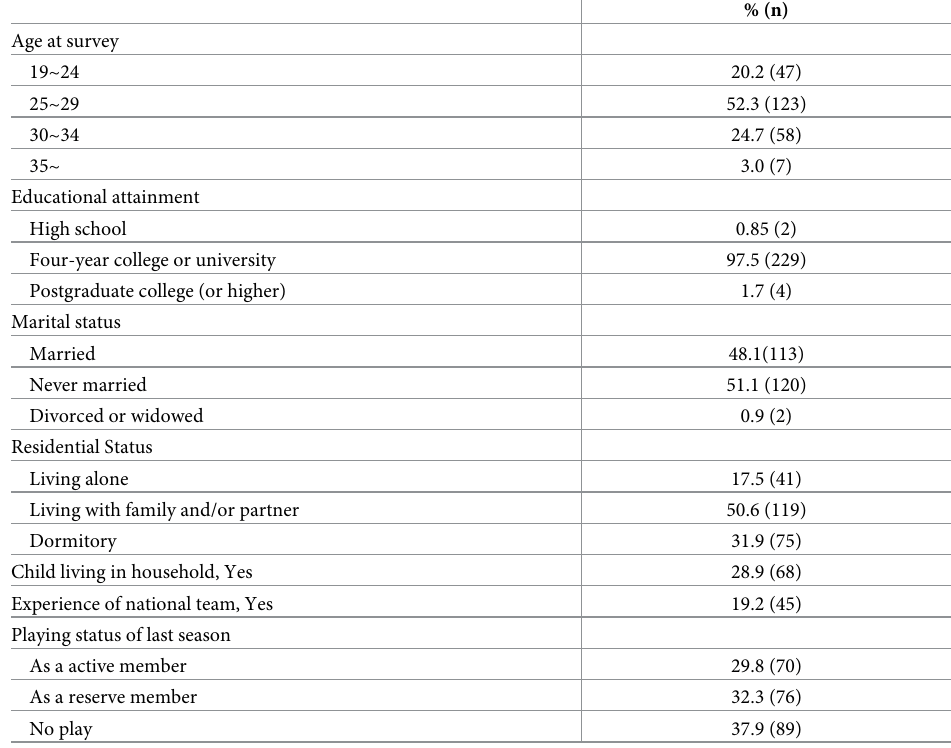
Table 1. Demographic and knowledge-attitude-behaviour related variables of the study participants.